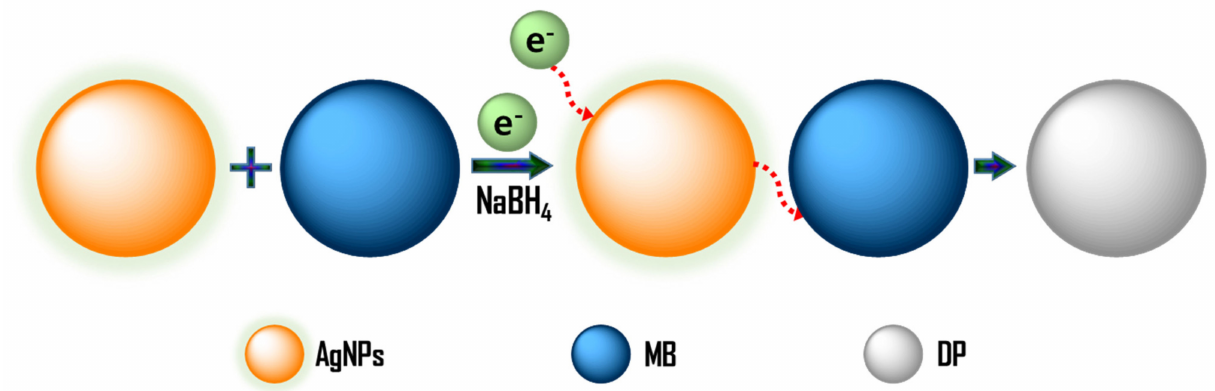
Figure 7. A plausible mechanism of methylene blue degradation in the presence of the prepared silver